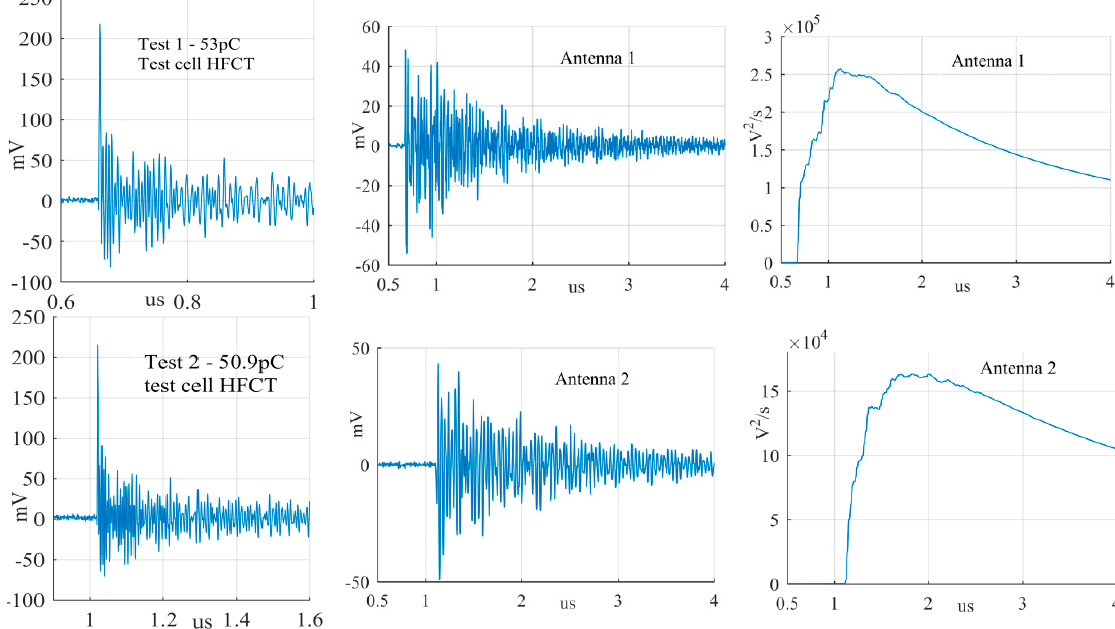
Figure 14. Largest free moving particle discharge from the antenna at position 1 and 2.